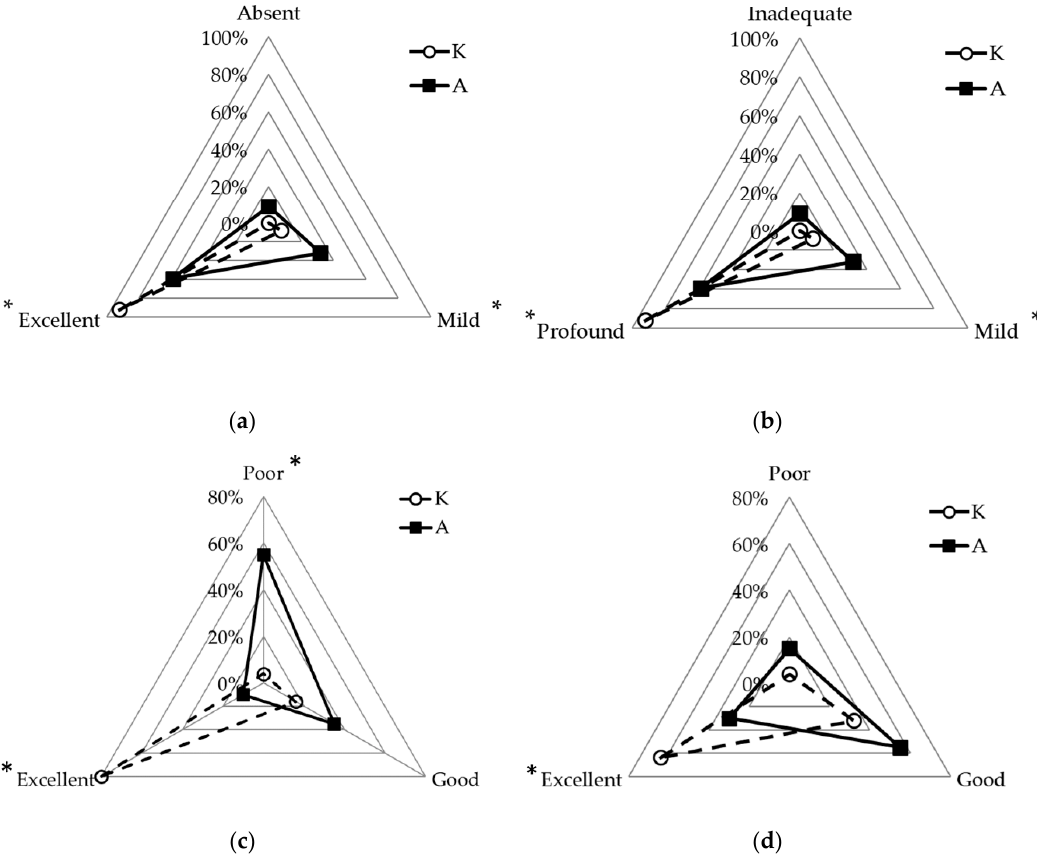
Figure 7. Radar charts for muscle relaxation ( a ), depth of anesthesia ( b ), recovery time ( c ), and quality ( d ) for wild gray squirrels undergoing gonadectomy, randomized to receive two anesthetic mixtures IM: Ketamine-dexmedetomidine-midazolam (group K, n = 25) and alfaxalone-dexmedetomidine-midazolam (group A, n = 22). Asterisks indicate the levels of each variable in which the differences between groups were significant at the 0.05 level .